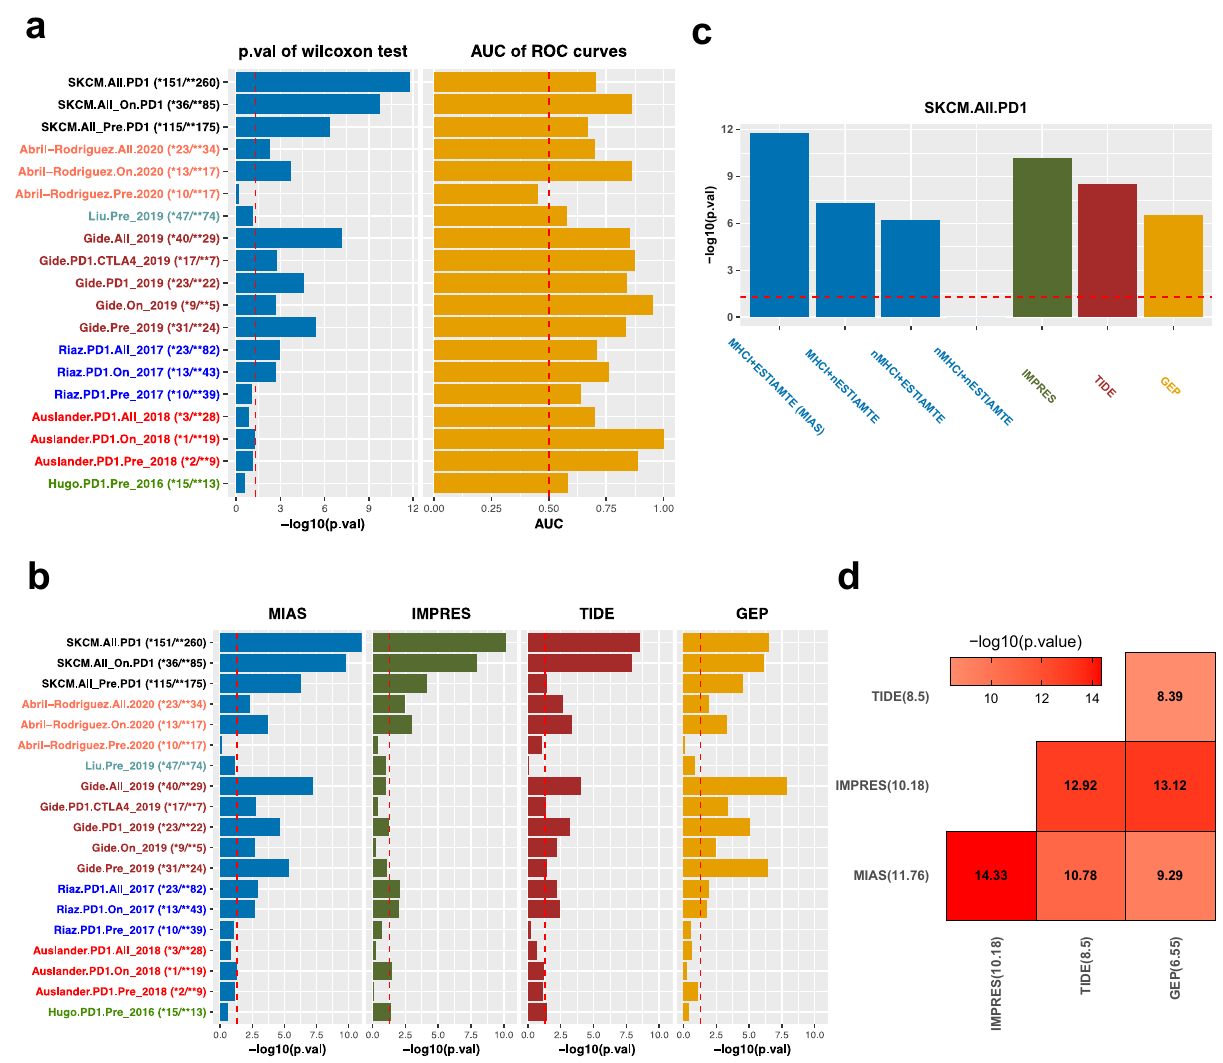
Fig. 6 Performance of response predictions to anti-PD-1 therapy. a p -values of one-sided Wilcoxon test and area under the curve (AUC) values of receiver operating characteristic (ROC) curves quantifying the predictive performance of our MIAS score for patient response to anti-PD1 across several melanoma patient cohort data sets: Auslander, Gide, Hugo, Liu, Riaz, Abril-Rodriguez, and the aggregated datasets (SKCM.All). “ Pre ” indicates before treatment; “ on ” , during treatment. The vertical dotted lines in the 2 bar plots respectively represent p -value = 0.05 and AUC = 0.5. Datasets of different cohorts are colored with different colors. b Performance comparison of our approach with three prior methods, IMPRES, TIDE, and GEP, using one-sided Wilcoxon test across the six melanoma patient cohort data sets. The dotted line in the bar plots represents p -value = 0.05. c Performance comparison of the four model scenarios with three prior methods using one-sided Wilcoxon test for all the 411 samples merged from all cohorts. The four model scenarios selected different signature genes for response prediction based on the combinations of the two major elements of MIAS (denoted MHC-I and ESTIMATE respectively) of our MIAS approach. The dotted line in the bar plots represents p -value of the Wilcoxon test = 0.05. d Performance of pairwise integrated predictions of MIAS and the three other methods for all the 411 samples. The color scale in the heat map graph indicates the statistical signi fi cance of prediction performance, − log10( p -value), calculated by the one-sided Wilcoxon test. The statistical signi fi cance of the performance of each individual method was also listed inside parentheses behind its name. The source data of all the panels in this fi gure are provided in the Source Data fi